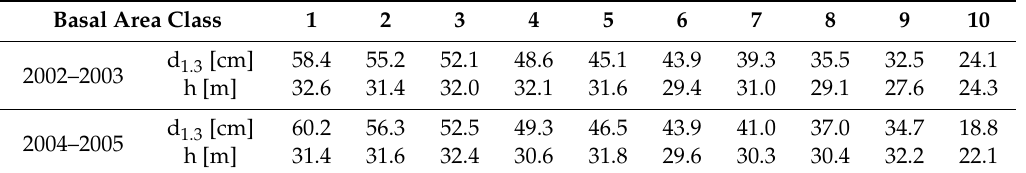
Table 1. Diameter at 1.3 m and tree height of the measured beech trees of ten basal area